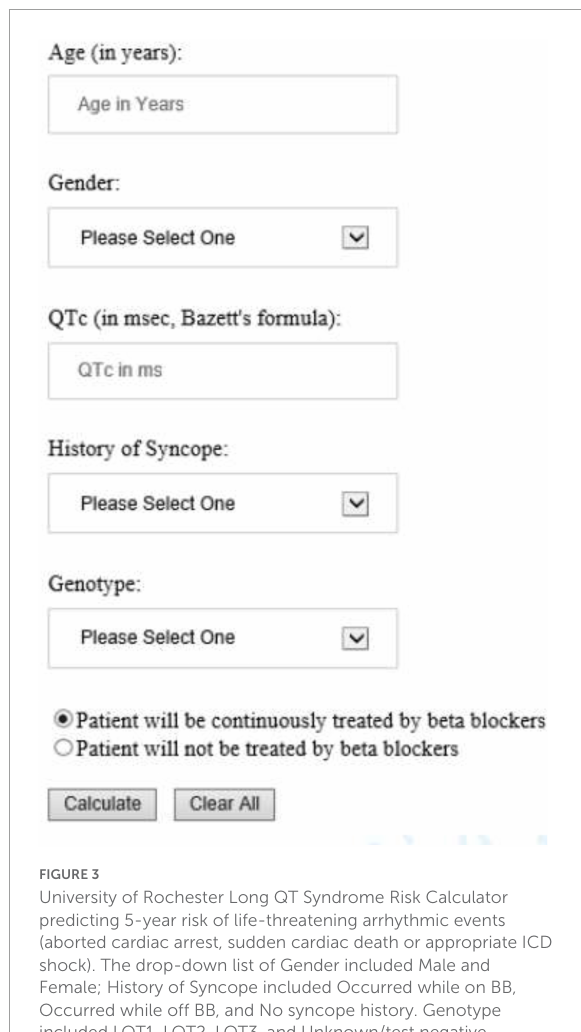
FIGURE3 University of Rochester Long QT Syndrome Risk Calculator predicting 5-year risk of life-threatening arrhythmic events (aborted cardiac arrest, sudden cardiac death or appropriate ICD shock). The drop-down list of Gender included Male and Female; History of Syncope included Occurred while on BB, Occurred while off BB, and No syncope history. Genotype included LQT1, LQT2, LQT3, and Unknown/test